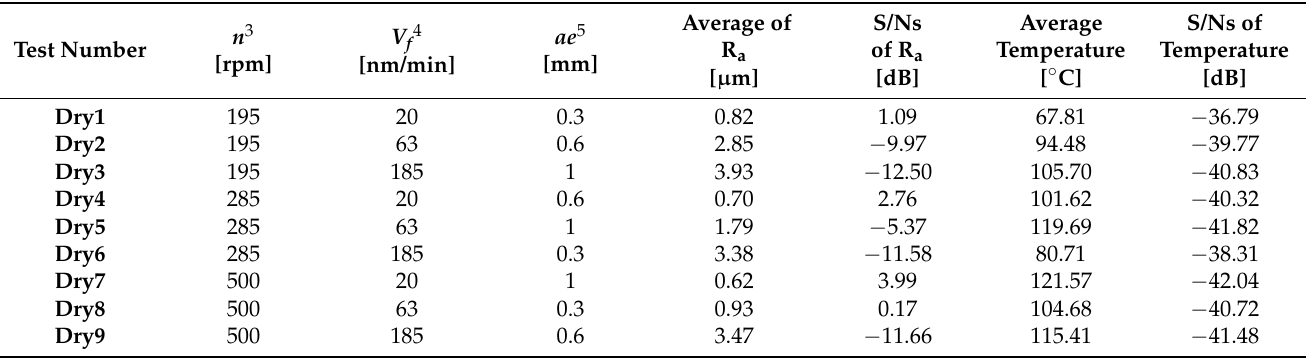
Table 5. Average surface roughness of the workpiece, average chip temperature value, and S/Ns ratio on the dry machining tests.